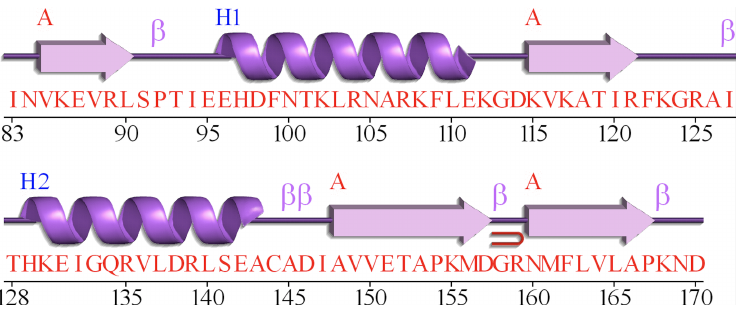
Figure 1. Protein 1TIG: Different symbols in purple represent different secondary structures, and red characters represent amino acid sequence. This figure is generated by PDBsum